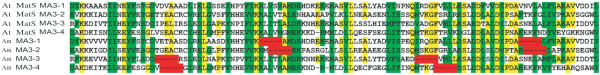
Comparison of the MA3 domains of A. thaliana with those of the basal angiosperm A. trichopoda. The individual MA3 domains of A. thaliana MAT5 (GenBank: NP_567708) and the basal angiosperm A. trichopoda (URDJ-37850) were aligned to show the relative positions of the deletions (highlighted in red) present in the MA3 domains of A. trichopoda PDCD4. Amino acid identity is highlighted in yellow, similarity is highlighted in green.